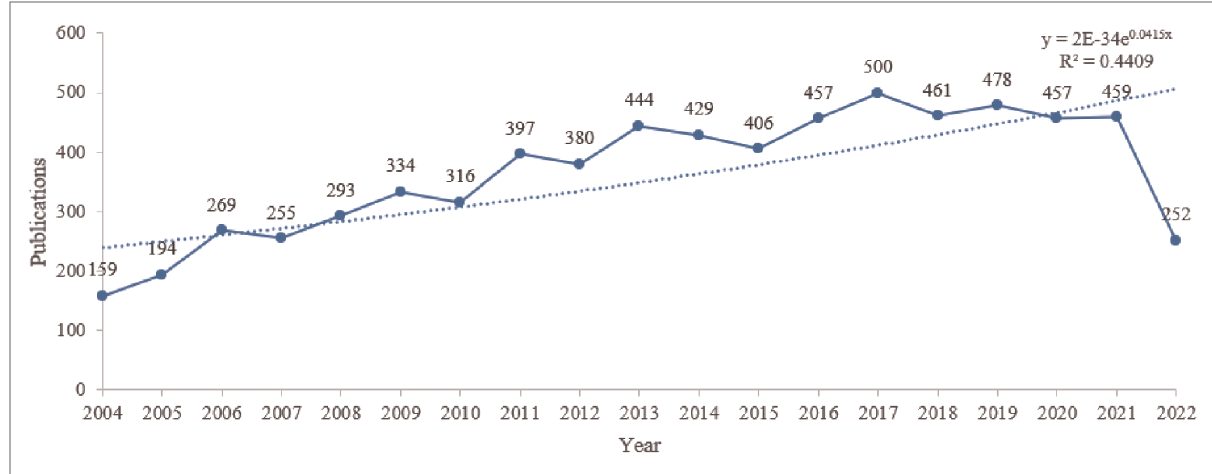
FIGURE 1 Trend of publications in original human studies on overactive bladder.